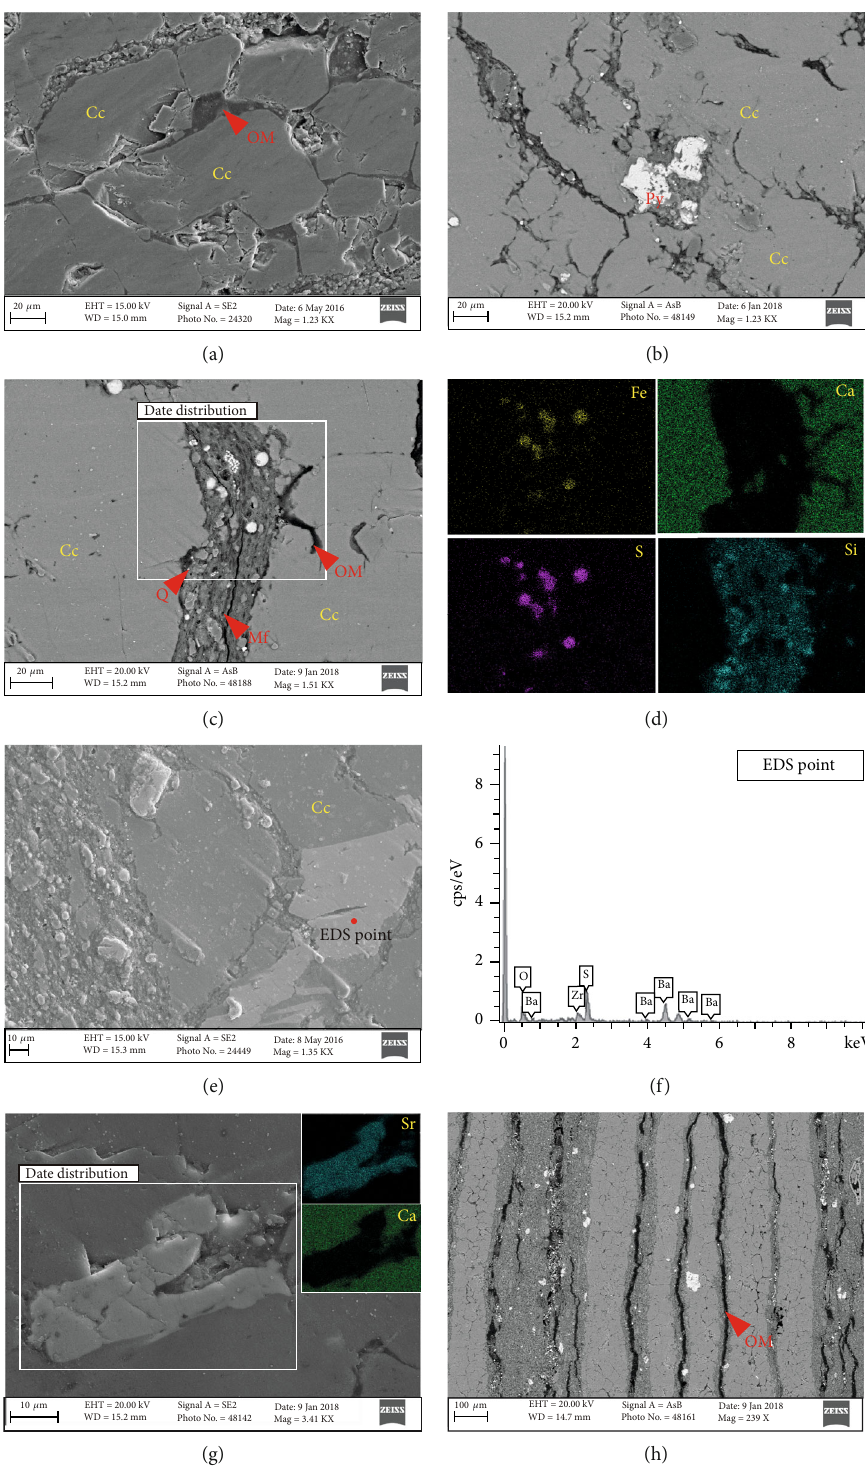
Figure 9: Calcite veins observed under the scanning electron microscope. (a) NY1, 3458.57m: the spaces between blocky calcite crystals are fi lled with clay minerals and OM. (b) FY1, 3197.27m: pyrite is packed in the fi brous calcite. (c, d) NY1, 3296.06 m: solid inclusions are present, and the microfracture (Mf) is subparallel to the calcite vein. The energy dispersive X-ray spectroscopy (EDS) image shows the mineral composition of the solid inclusion. Pyrite framboids, quartz grains, and OM are present on the margin of the calcite vein. (e, f) FY1, 3413.44m: barite appears in the fi brous calcite veins. (g) FY1, 3197.27m: strontianite appears in the fi brous calcite veins. (h) NY1, 3458.57m: bedding-parallel calcite veins have blocky crystals. Between these veins are solid inclusions associated with clay minerals and OM. Cc: calcite; Py: pyrite: Q: quartz; Mf: microfracture; OM: organic